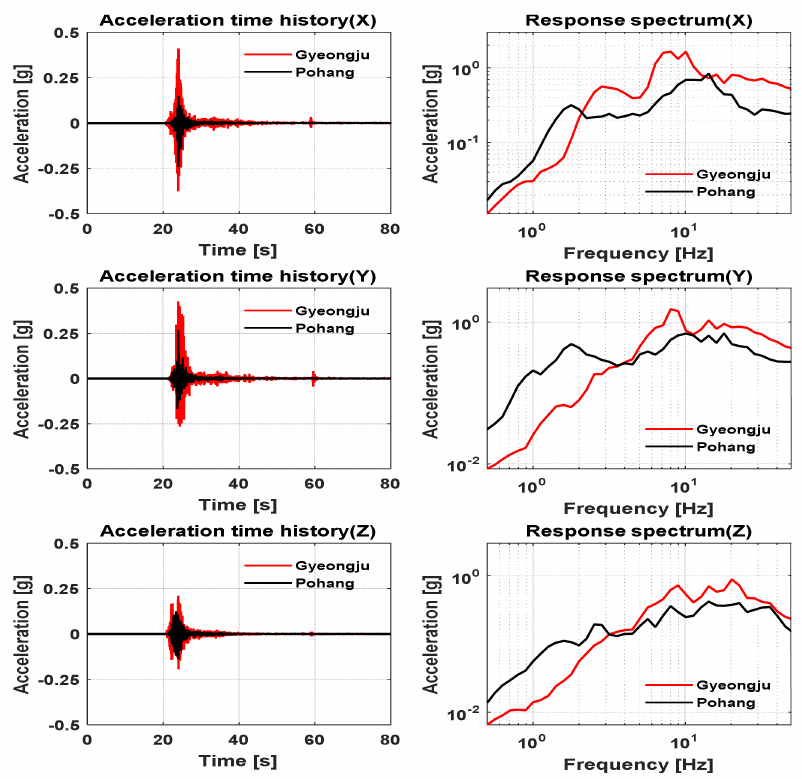
Figure 5. Acceleration time histories and response spectra for Gyeongju (USN) and Pohang (PHA2)